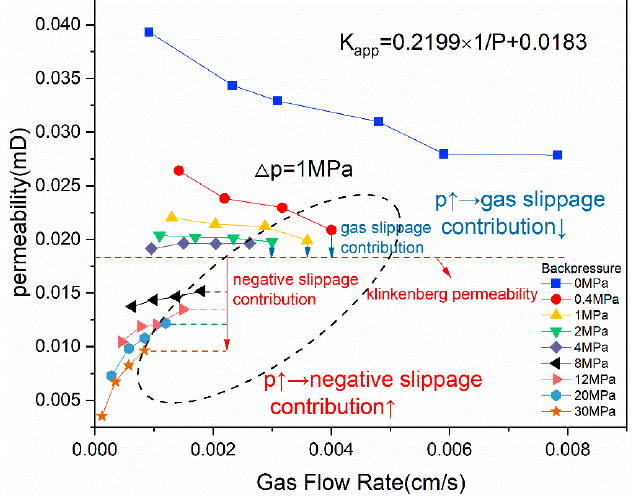
Figure 5. Permeability versus flowrate at diverse backpressures for core Z2.